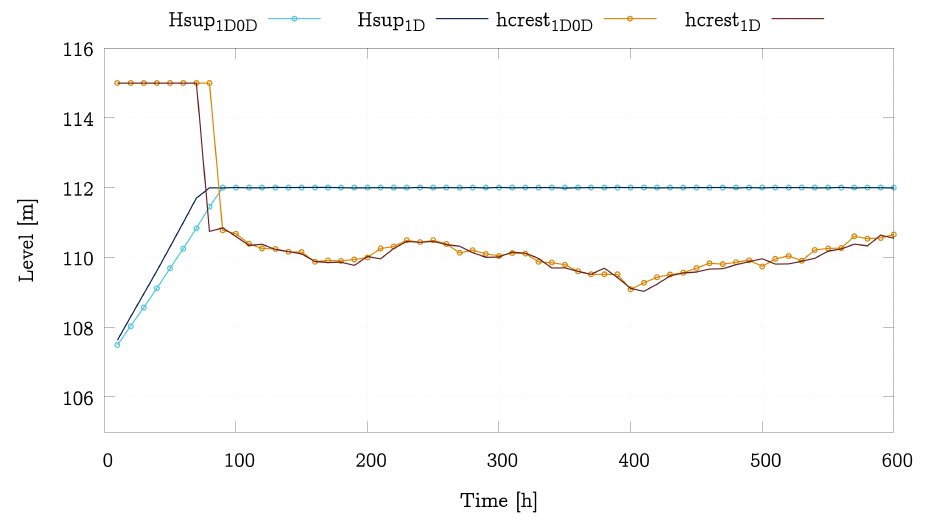
Figure 14. Temporal evolution of the water level and dam crest computed with the fully 1D model and the coupled 1D-0D model for the 2015 case with the control of a PID algorithm.